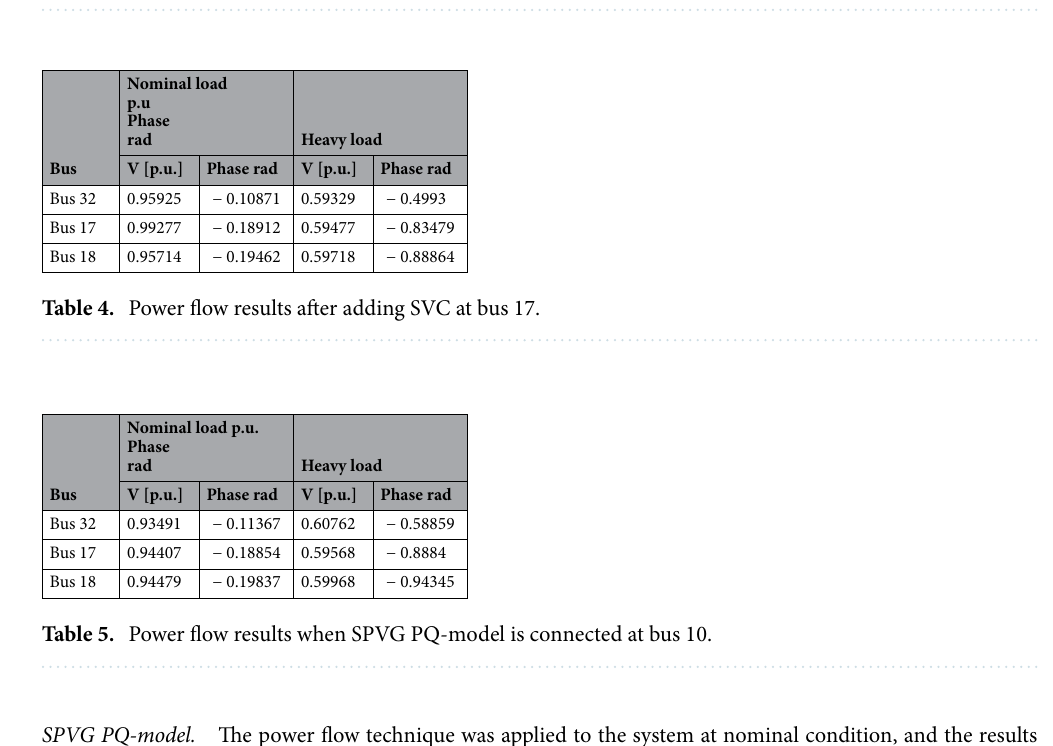
Nominal load p.u